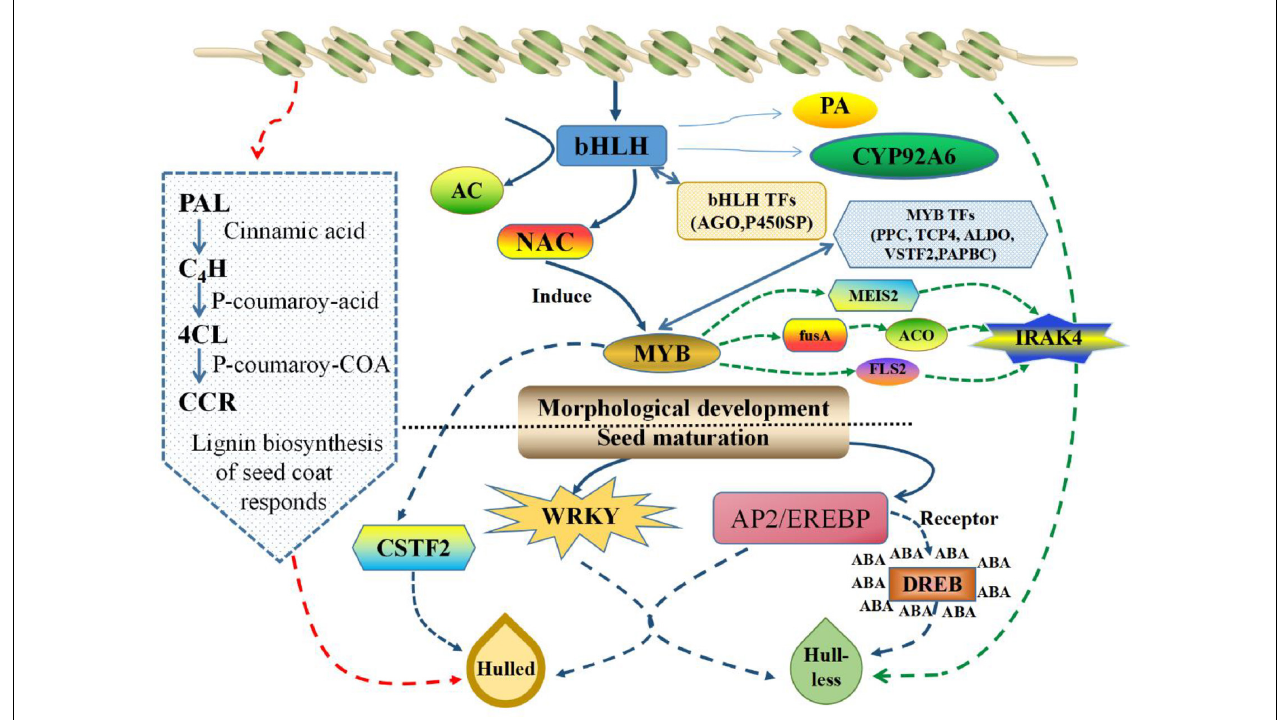
FIGURE 10 | Summary of the molecular pathways and cellular processes involved in hull-less seed coat formation in C. pepo . The red line indicates the path of gene-level regulation, blue line represents the regulation of transcription factor level, and green line represents the action based on PPIs. The dashed arrows represent these genes that needs functional verification. The solid arrows indicate that the gene function has been reported.